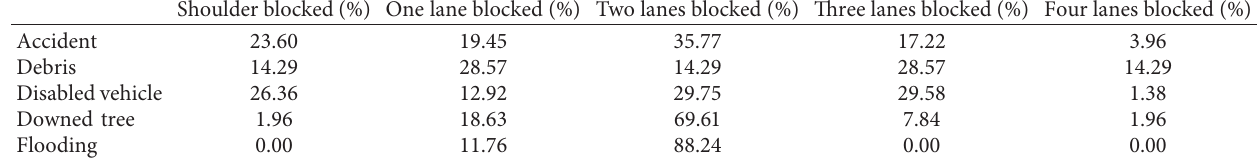
Table 2: Capacity loss caused by various incident types.